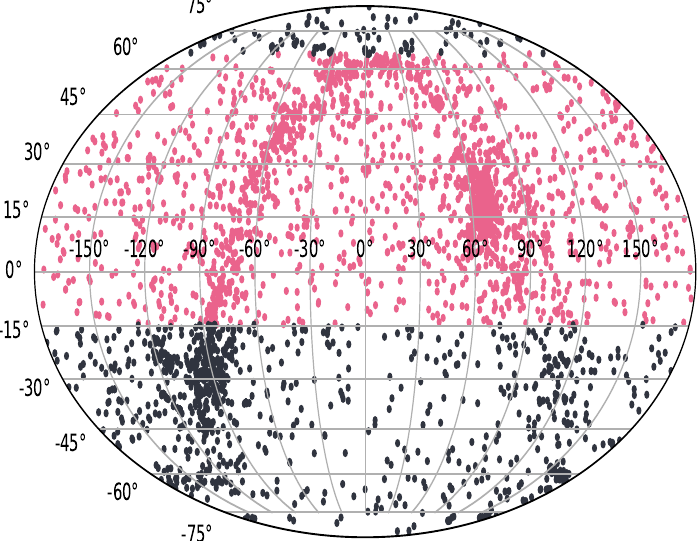
Figure 8. Position distribution of radio stars; red points are within the observational field of the FAST